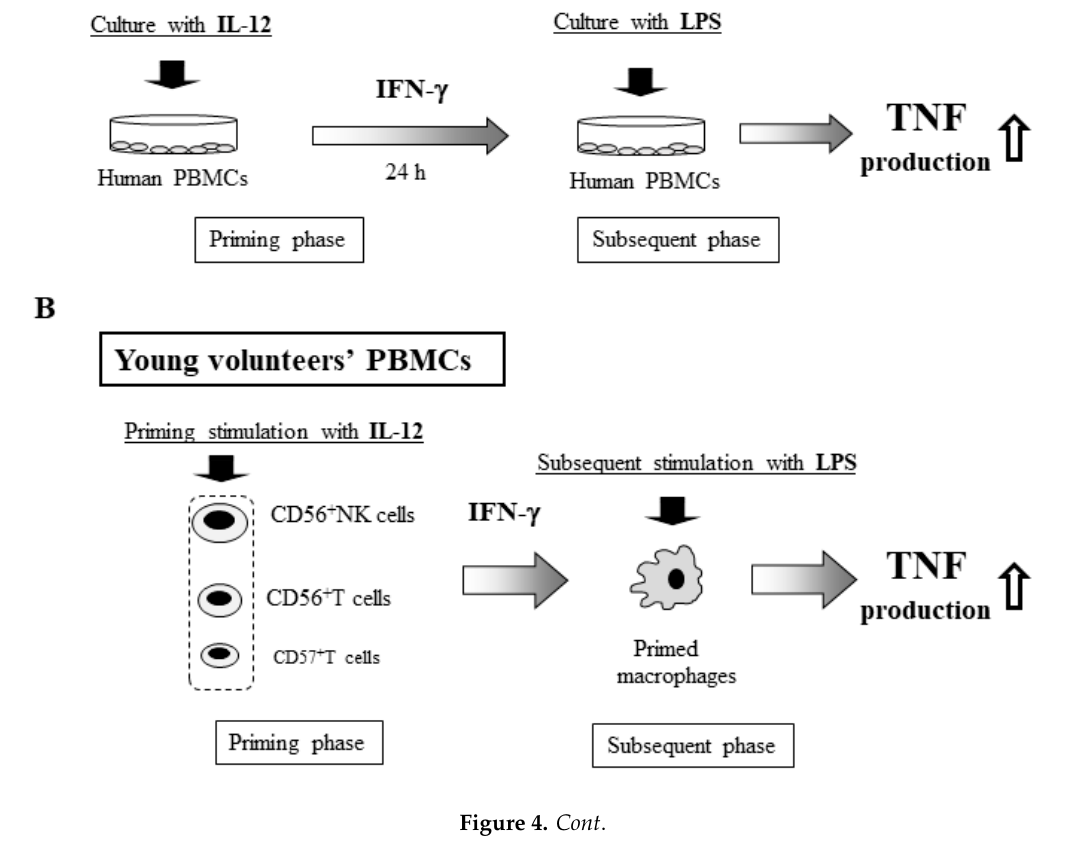
Figure 4. The in vitro Shwartzman reaction-like response in human peripheral blood mononuclear cells (PBMCs). ( A ) IL-12 stimulation and subsequent LPS stimulation 24 h later induced enhanced TNF production in cultured human PBMCs, suggesting an in vitro Shwartzman reaction-like response. ( B ) In PBMCs from young volunteers, IL-12 priming activates CD56 + NK, CD56 + T, and CD57 + T cells to produce IFN- γ , which primes macrophages. Subsequent LPS stimulation strongly activates the primed macrophages to produce large amounts of TNF, suggesting an in vitro